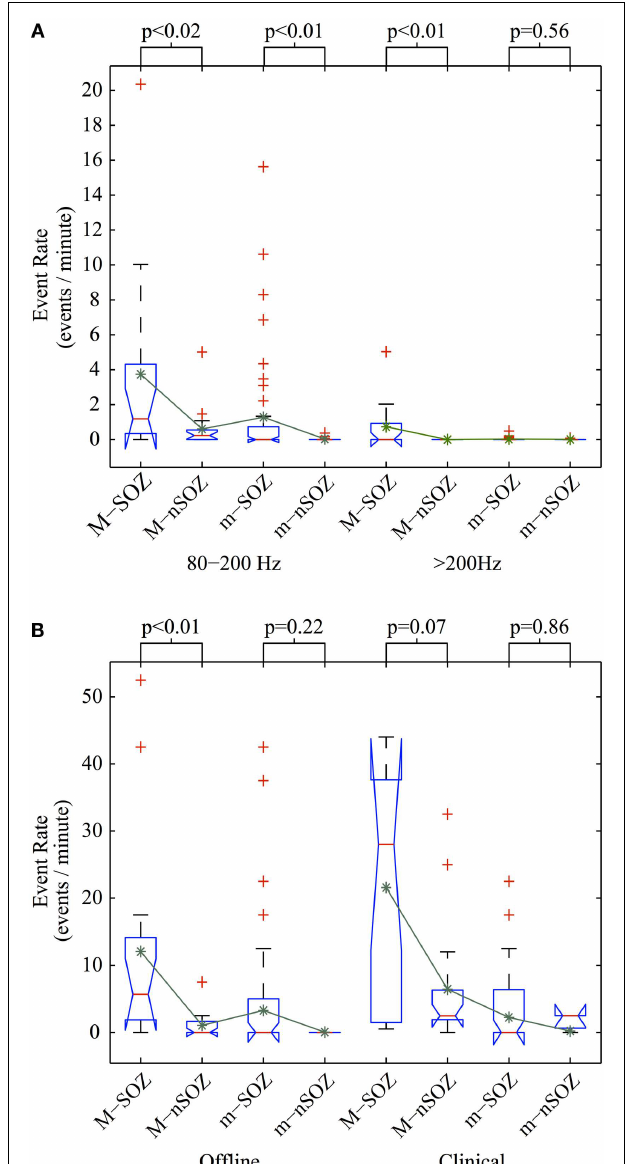
FIGURE 5 | Comparison of HFO detection rates . Event detection rate per electrode using (A) semi-automated offline methods on full-duration recording segments and (B) semi-automated offline methods (left) and manual review (right) for identical recording sub-segments with excluded micro-contacts ignored. Abbreviations used are as follows: M, macro-contact; m, micro-contact; SOZ, seizure onset zone; nSOZ, non-seizure onset zone. Kruskal–Wallis analysis of variance was used to test for significant differences in the mean across three groups: contact type (m vs. M), brain region of interest (SOZ vs. nSOZ), and either HFO frequency range (80–200 vs. > 200Hz in A: test statistic = 71.5, p < 0.001) or event detection method (offline vs. clinical in B: test statistic = 30.6, p < 0.001).The p values for post hoc Wilcoxon rank-sum tests are shown above the box plots. Red lines indicate the median; lower and upper borders of blue boxes represent 25 th and 75 th percentiles, respectively; lower and upper black whiskers correspond to one interquartile range below the 25 th and above the 75 th percentile, respectively; red pluses depict outliers; and green asterisks show the